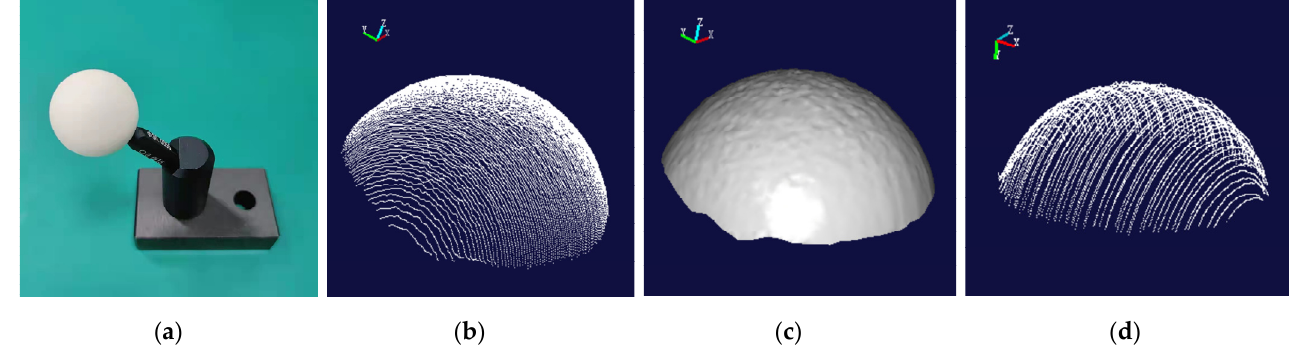
Figure 19. The related images of the standard sphere. ( a ) The original image. ( b ) The point cloud image based on binocular camera positioning. ( c ) The rendering image based on ( b ). ( d ) Point cloud image based on robot positioning.